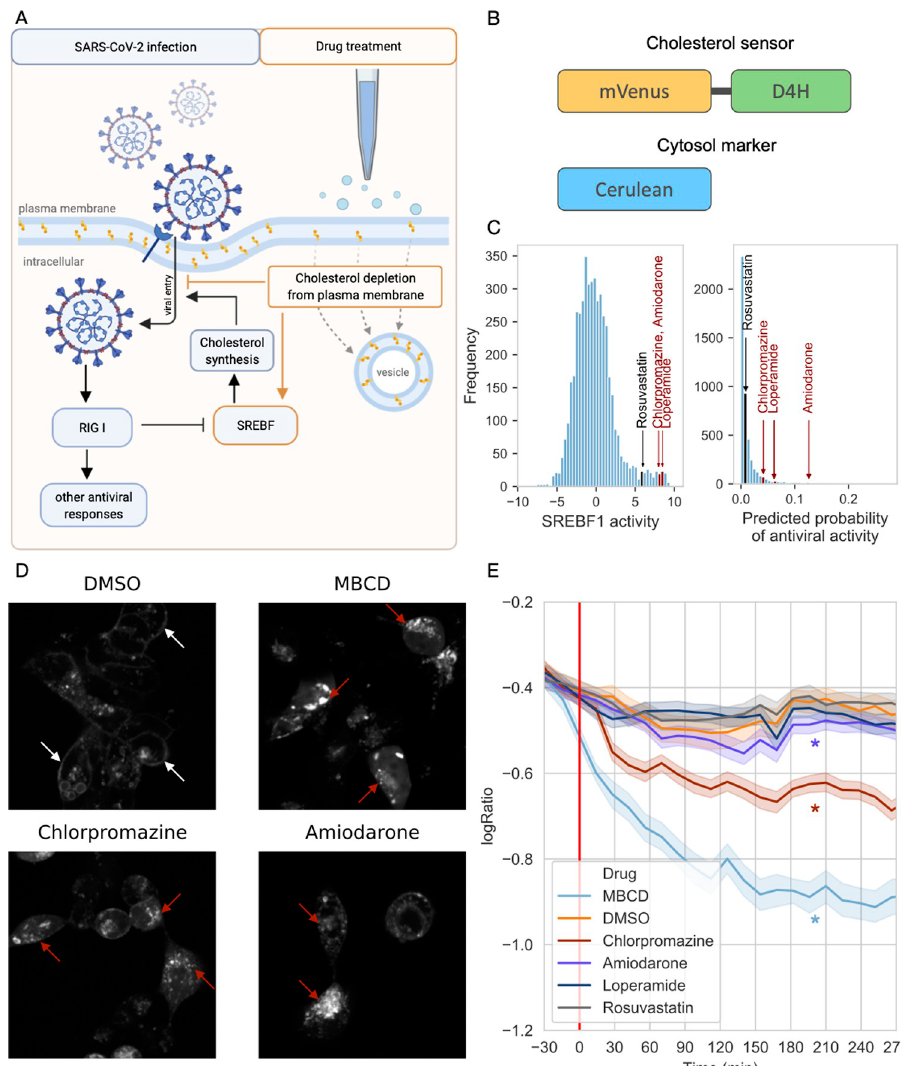
Fig 4. Cholesterol depleting effect of SREBF activating drugs. (A) Schematic figure of the hypothesis that antiviral drugs block virus entry into cells by cholesterol depletion from plasma membrane, and are leading to a compensatory increased SREBF1/2 activity. Effects induced by viral infection are marked with black arrows (left side), while orange arrows represent drug-induced changes (right side) The figure was created with BioRender.com. (B) Schematic representation of the used fluorescent constructs. (C) Histogram of SREBF1 activation (left panel) and histogram of predicted probabilities of in vitro antiviral activity of LINCS-L1000 drugs (right panel, according to the Random Forest model). Drugs selected for in vitro experiments are text labeled. (D) Representative confocal microscopy images of D4H-mVenus transfected HEK293A cells treated with DMSO, M β CD, chlorpromazine or amiodarone. White arrows mark plasma membrane, while red arrows show intracellular localised cholesterol sensors. (E) Time-dependent change of log 2 (PM/IC) ratio of average cholesterol sensor intensity in HEK293A cells treated with DMSO, M β CD, chlorpromazine, amiodarone, loperamide or rosuvastatin. Red line marks drug treatment. � : significant (p < 0.001) interaction between drug treatment and elapsed time in linear